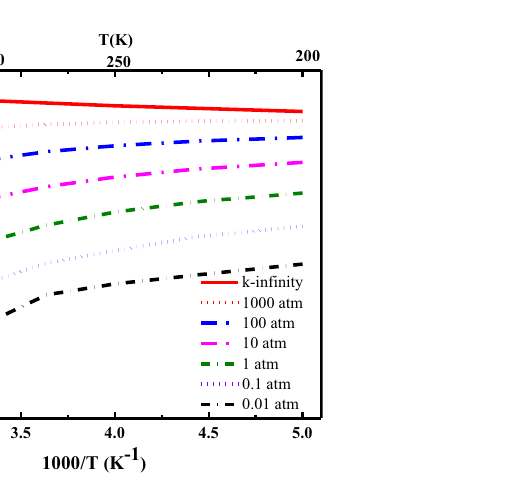
Figure 5. Temperature-and pressure-dependent rate constants for CH 2 NH + H 2 O → CH 2 NH ⋯ H 2